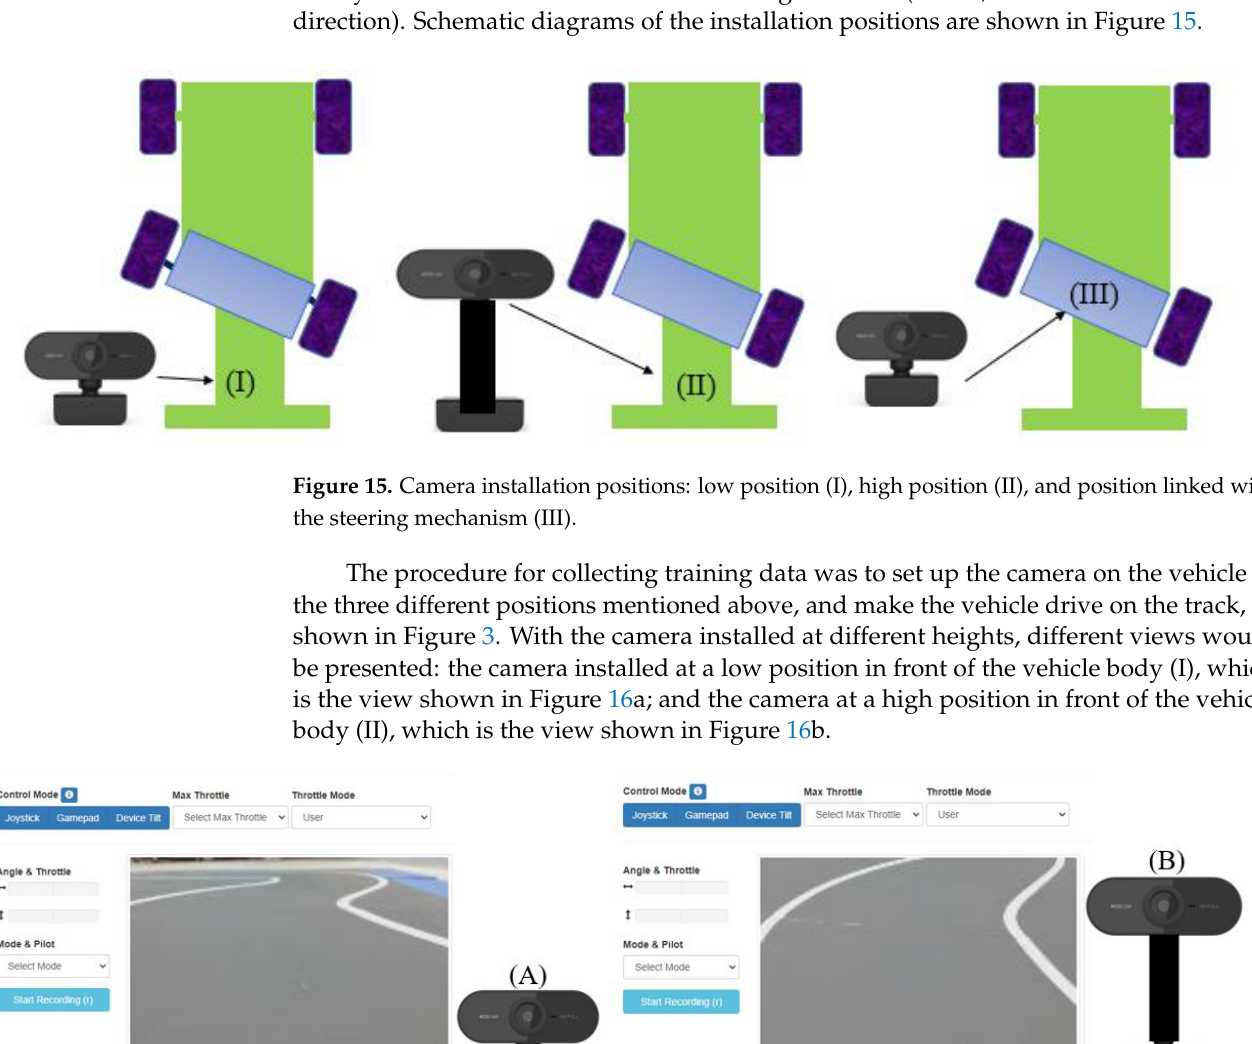
Figure 16. Experimental field: ( a ) the view from position (I), ( b ) the view from position (II).